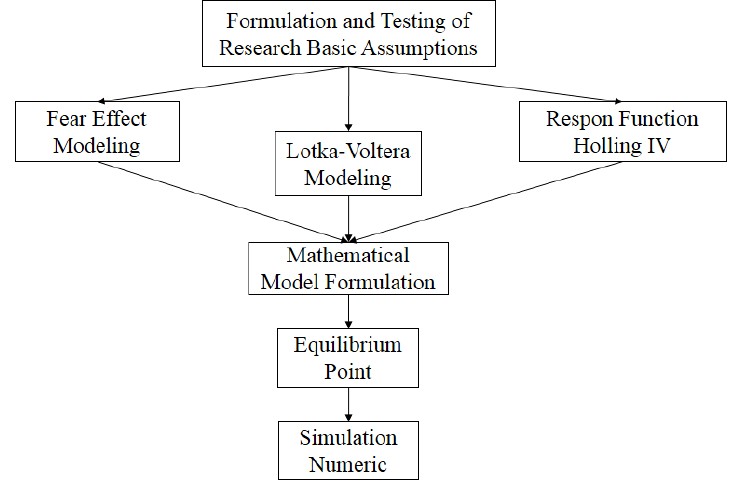
Figure 2. Research flow